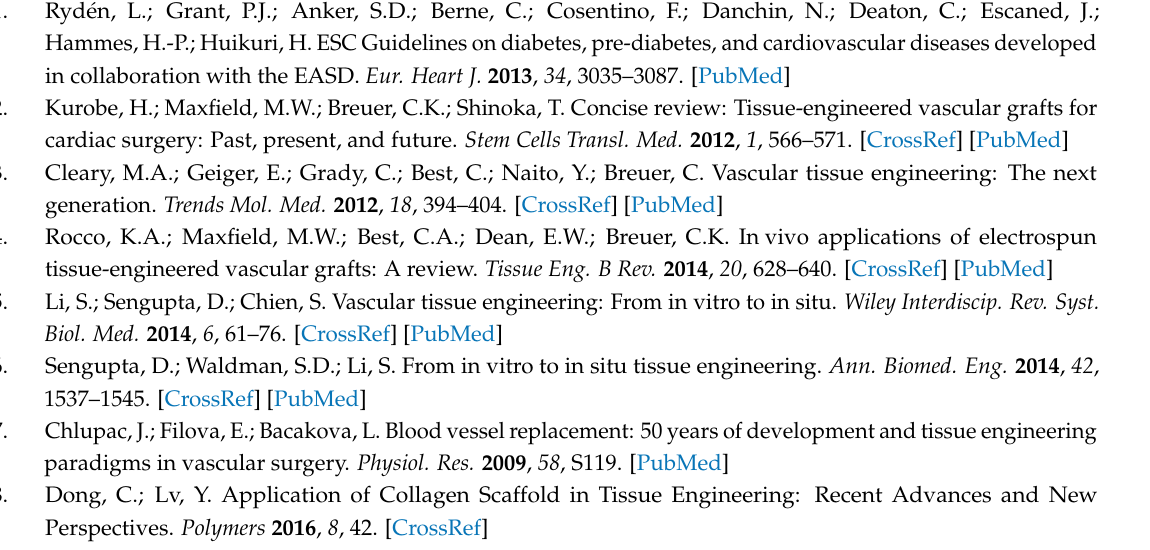
Figure S1: Fabrication PDMS chambers from PMMA substrates. Figure S2: Fabrication scaffolds without cells. Figure S3: Fabrication scaffolds with cells. Figure S4: Setup for burst pressure test. Figure S5: Setup for water leakage and compliance tests. Figure S6: Fabrication scaffolds with stained cells (illustrating the cell distribution for cell migration test by a fluorensent assay). Figure S7: Fabrication scaffolds with one layer of cells seeded (illustrating the cell distribution for cell adhesion, proliferation and migration tests by SEM). Figure S8: The morphology of PLGA fibers before and after 14 days’ degradation in DMEM at 37 ◦ C with 5% CO 2 . Figure S9: The 0.25% methyl cellulose solution leakage from the scaffolds. Figure S10: Cell adhesion after 12 h on PLGA ES films. Figure S11: The pressure-inner diameter curve of the scaffolds. Figure S12: The calibrated standard curve of the CyQuant Cell Proliferation Assay Kit. Figure S13: SEM images of and cell proliferation and cell migaration after 3 and 6 days in scaffolds. Figure S14: A possible design for the solution to the internal edge of the rolling-based scaffolds. Table S1: The relationship between circumferential tensile strain and the Cauthy stress of the